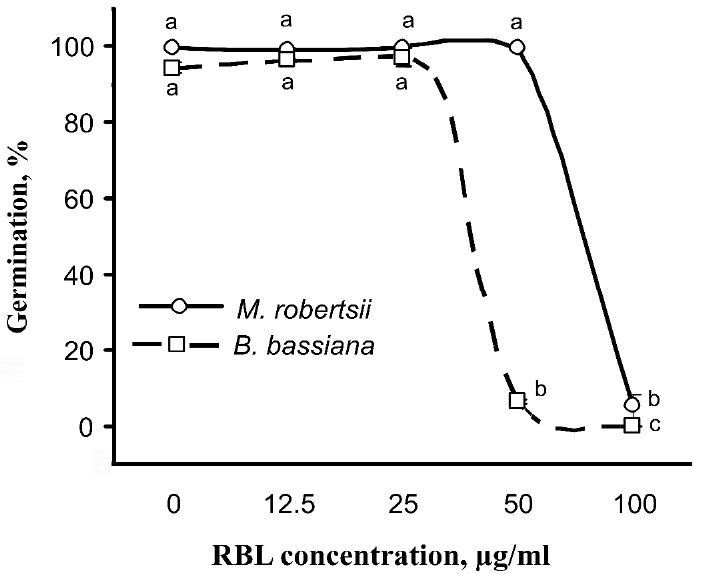
Figure 7. Effect of RBL R. communis on germination of M. robertsii and B. bassiana conidia in Sabouraud broth after 36 h of incubation. Different letters show significant differences between all treatments (Tukey’s test, p < 0.05).